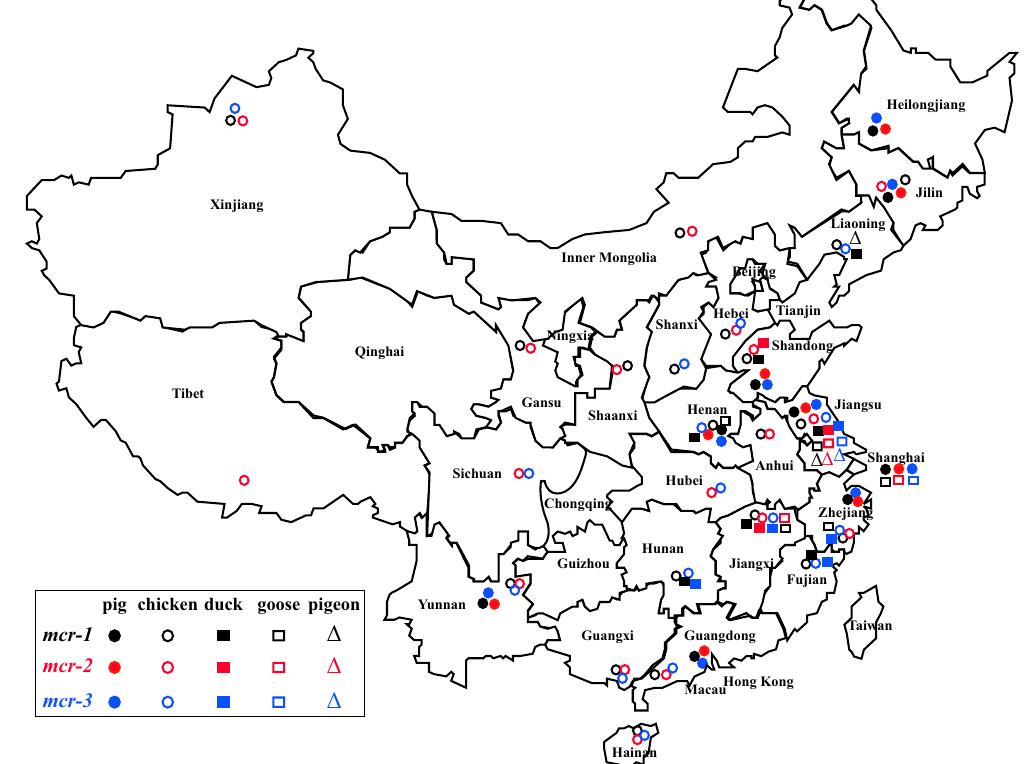
Figure 1. Distribution of mcr-1 , mcr-2 and mcr-3 in pigs and poultry. The mcr were detected in specimens from 25 provinces/municipalities of China ( mcr-1 : 2,147/4,895; mcr-2 : 926/4,895; mcr-3 : 409/4,895). The prevalences of the mcr were much higher in pigs ( mcr-1 : 79.2%, 1,152/1,454; mcr-2 : 58.4%, 818/1454; mcr-3 : 17.3%, 272/1454) than in poultry ( mcr-1 : 33.0%, 606/1,836; mcr-2 : 4.8 88/1,836; mcr-3 : 5.7%, 105/1,836). The colors (dark, red, blue), shapes (circle, rectangle, triangle) and positions of filled and empty graphics indicate the mcr positivity, species sampled and the cities involved, respectively. The Adobe Illustrator CS 11.0.0 was used to create the map in this